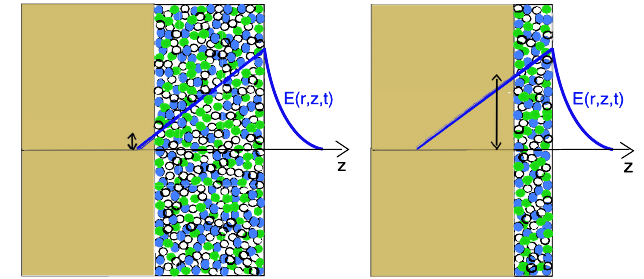
FIG. 7. C-H-O contamination layer on the target surface (not true to scale) and the electric field E ð r; z; t Þ reaching into the foil: no laser desorption (left) and with laser desorption (right). Because of the thinner contamination layer in the right image, metal atoms experience a sufficiently strong electric field to get ionized and accelerated. This is not the case in the left image, where the electric field gets strongly screened by the